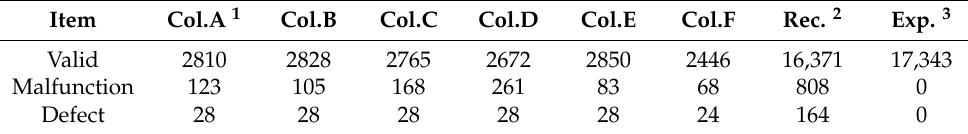
Table 2. The overall statistics about the number of data packets recorded by all the 41 indoor slave nodes in the WSN